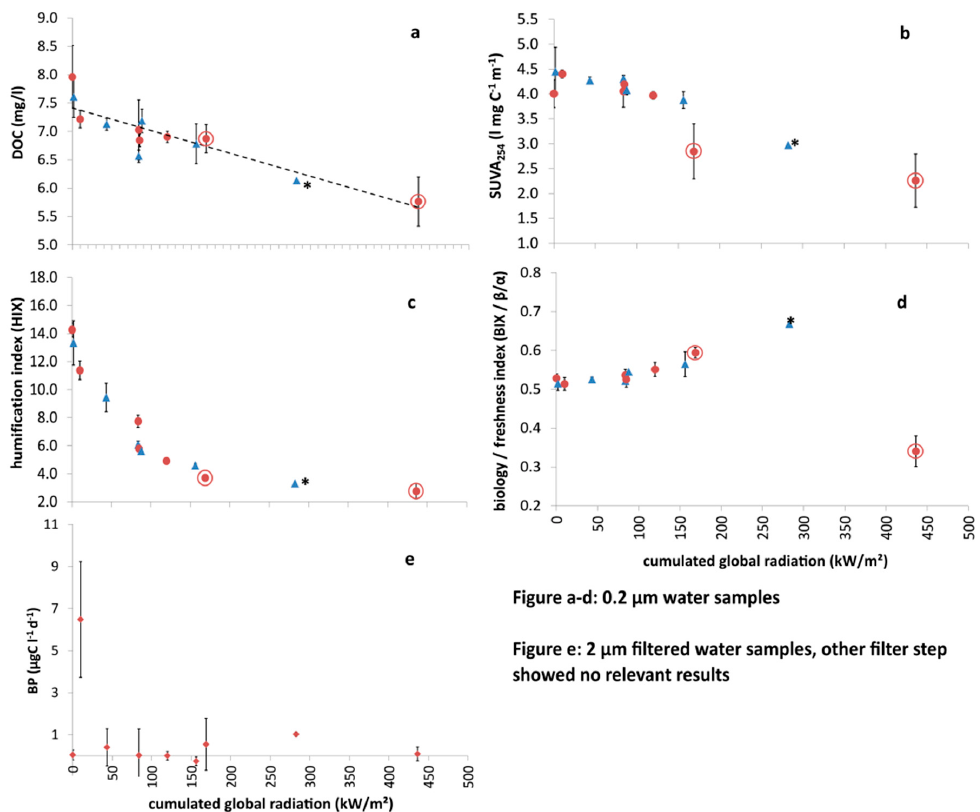
Figure 2: Mean values and the standard deviations of DOC ( a ), the specific UV absorbance at 254 nm (SUVA 254 ) ( b ), the humification index ( c ), the freshness index ( d ) vs. cumulated global radiation of the 0.2 µm filtered water and ( e ) the dynamic of planktonic bacterial production vs. cumulated global radiation of the 2 µm filtered water. The circular red points represent the averages of the three replicates of Rote Mulde (RMU) 1–3 and the triangular blue ones the replicates of RMU 4–5. The dotted line in ( a ) represents a regression line r 2 = 0.81. Dots marked with * are median of the water samples and had no standard deviations, because there were only 2 instead of 3 replicates.